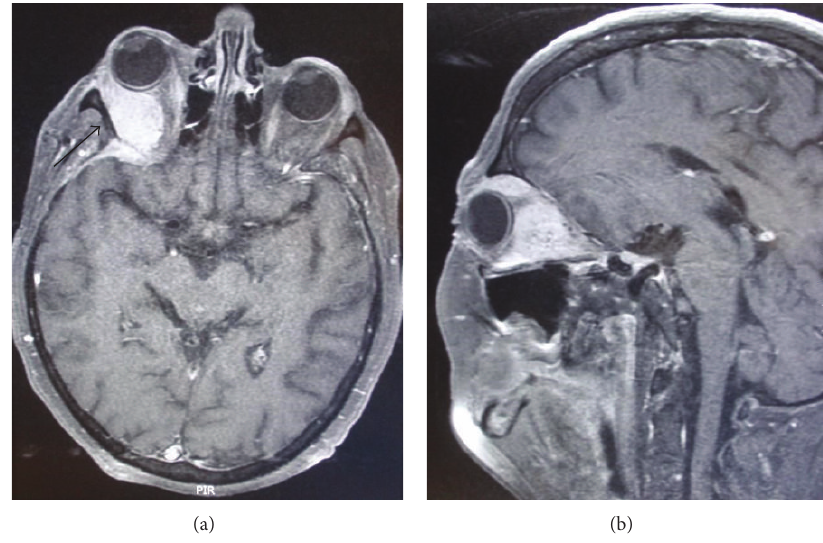
Figure 2: MRI: (a) T2-weighted MRI image of the head showing intraorbital mass and scar tissue (arrow) from previous operation. (b) On contrast T1-weighted image, the intraorbital mass may be clearly seen, as well as